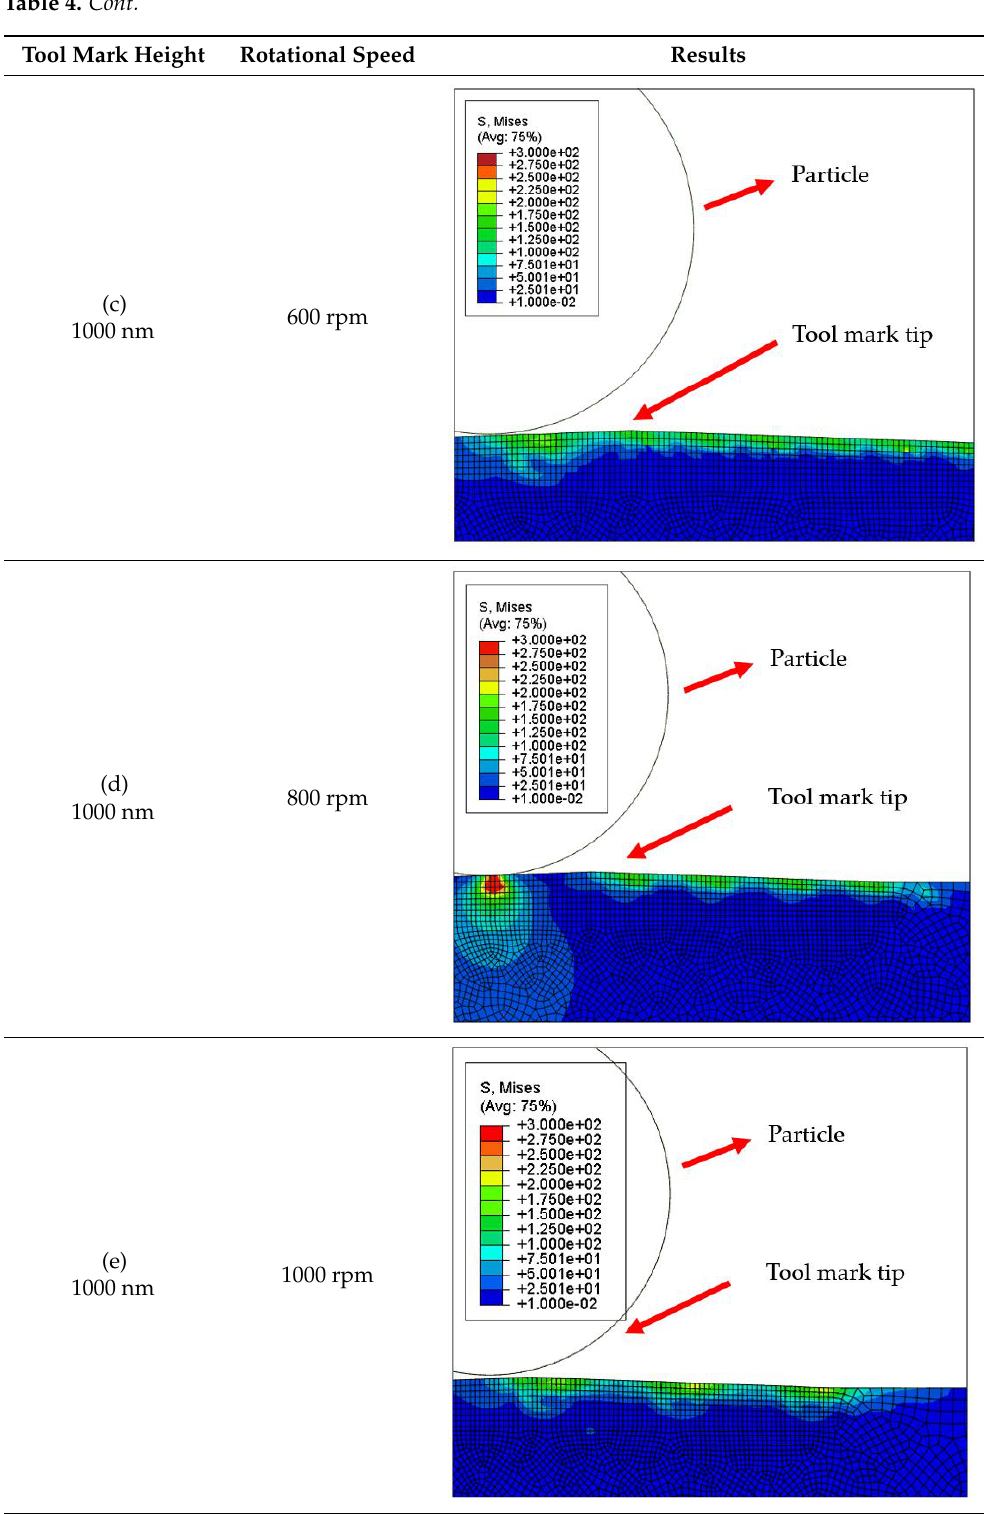
Table 5. The 20 nm high tool mark workpiece surface under particle impact at different